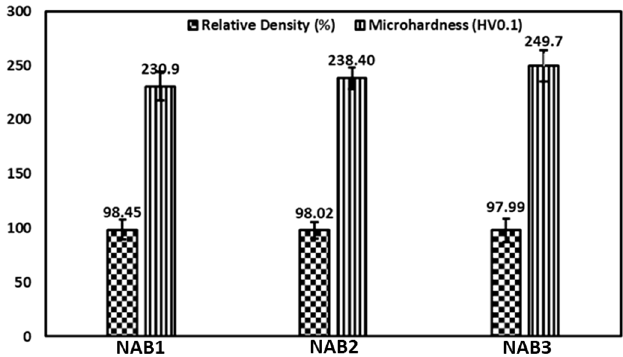
Fig. 6. Relative density and microhardness of the fabricated NAB